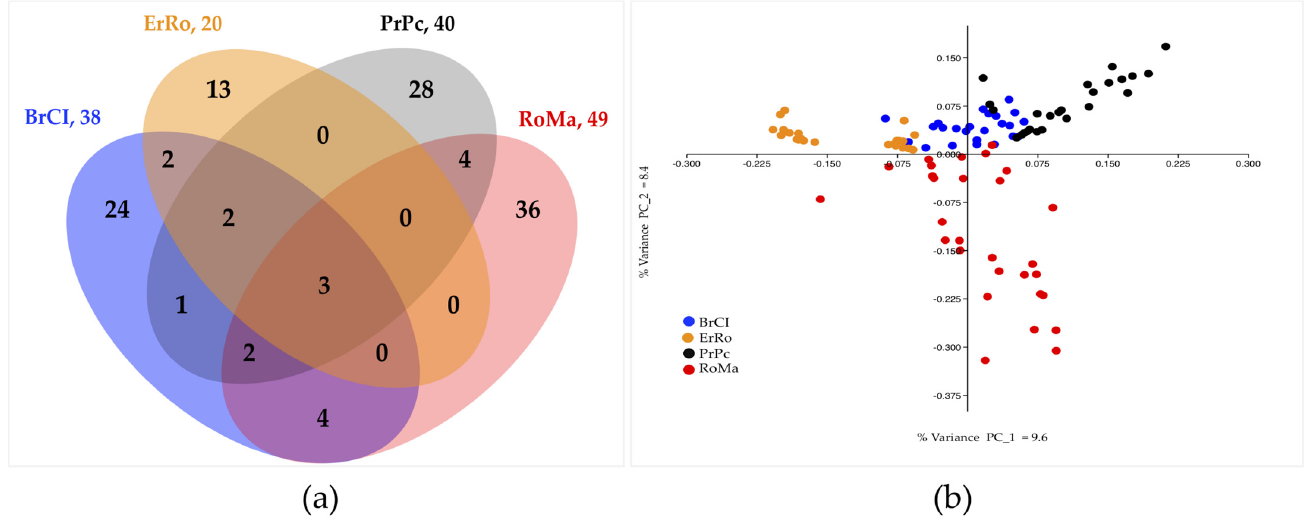
Figure 2. ( a ) Venn diagram of shared and breed CNVRs (n. 147 in total) of each turkey breed here analyzed; ( b ) Principal Component Analysis result; PC_1 vs. PC_2 percentage variance values are plotted.